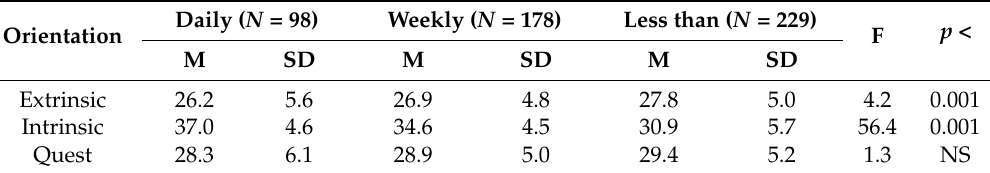
Table 4. Mean scale scores by Bible reading.